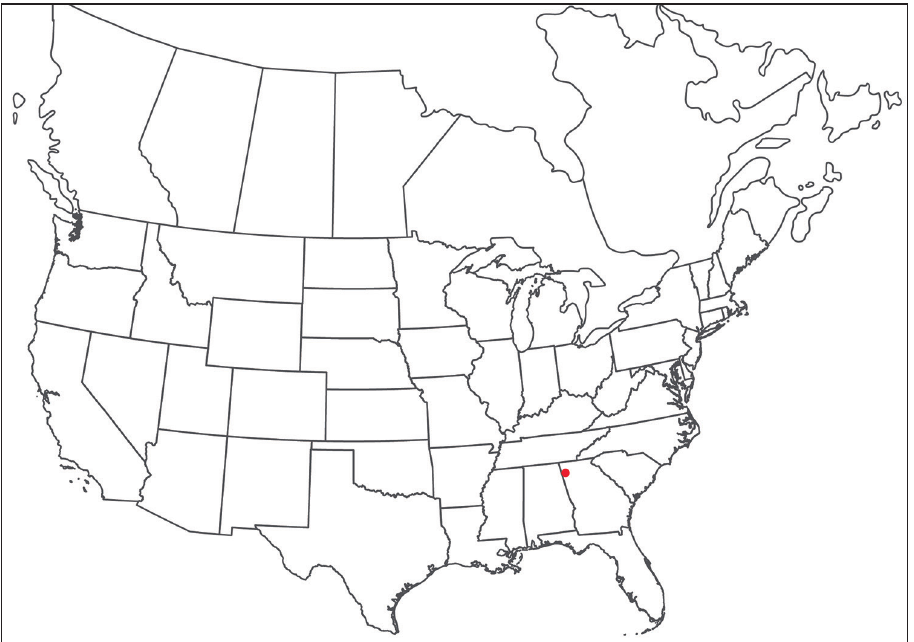
Figure 75. Torrenticola feminellai sp. n.